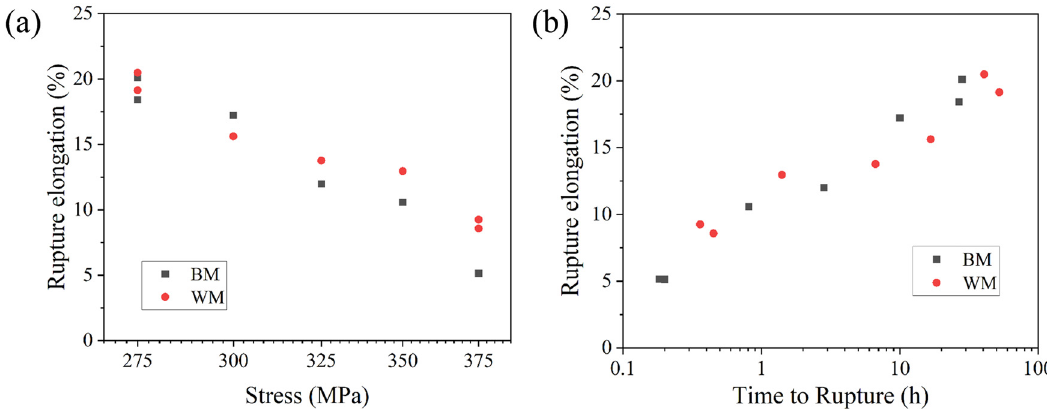
Figure 8: Variation of rupture elongation with respect to ( a ) applied stress and ( b ) time to rupture for BM and WM